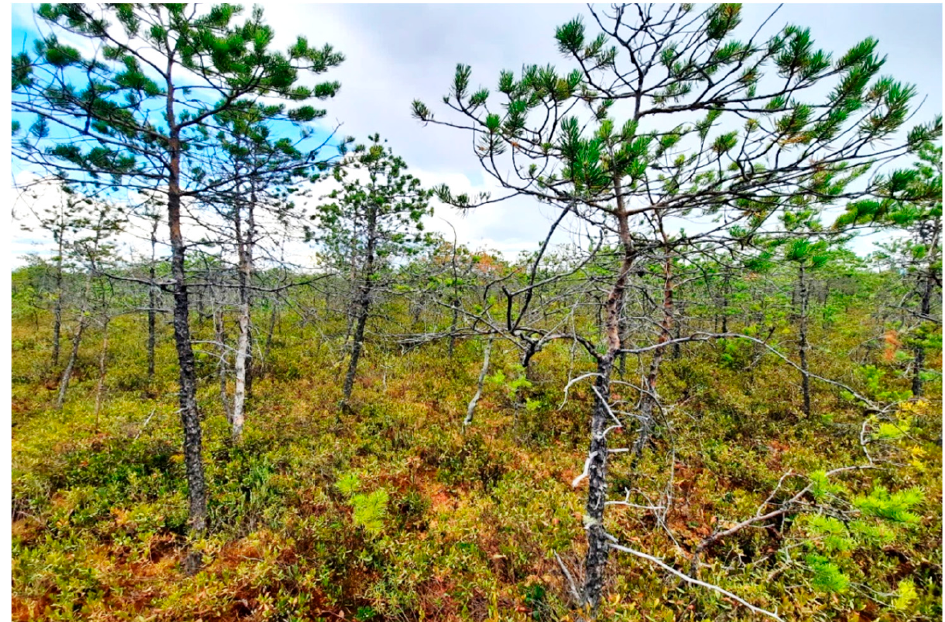
Figure 4. Field study area within the Great Vasyugan Mire.